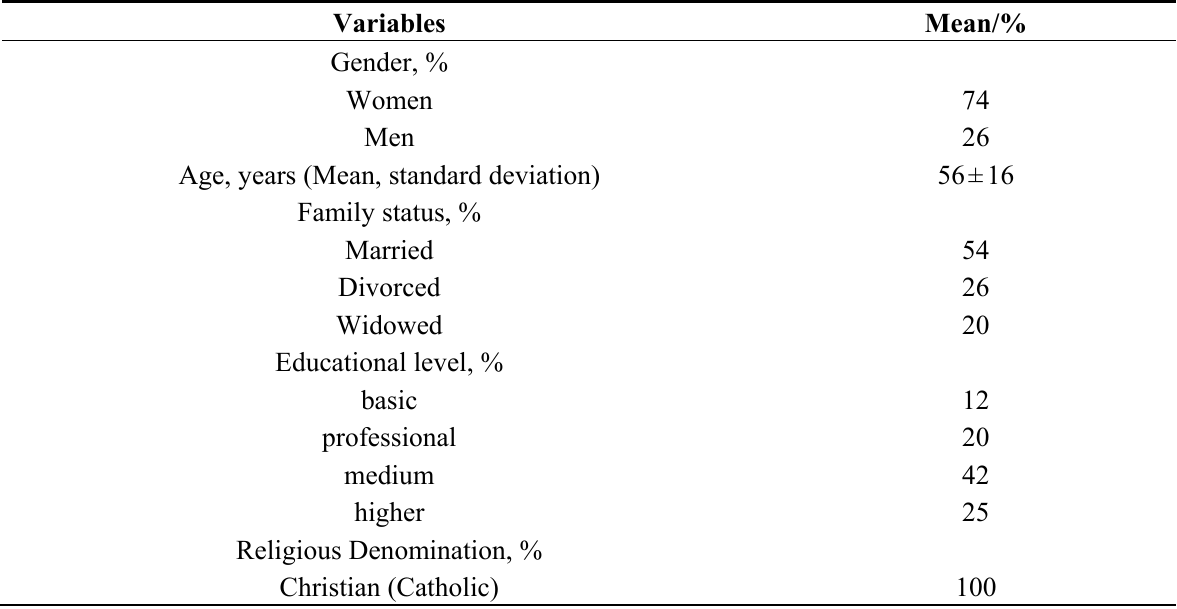
Table 1. Characteristics of 275